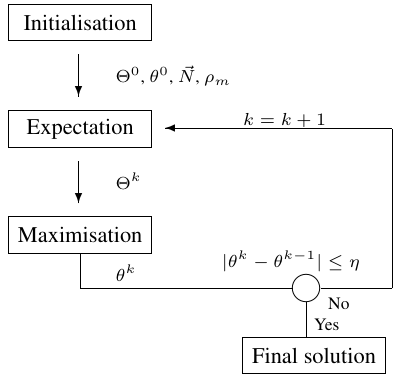
Figure 4: Iterative segment adjustment algorithm.